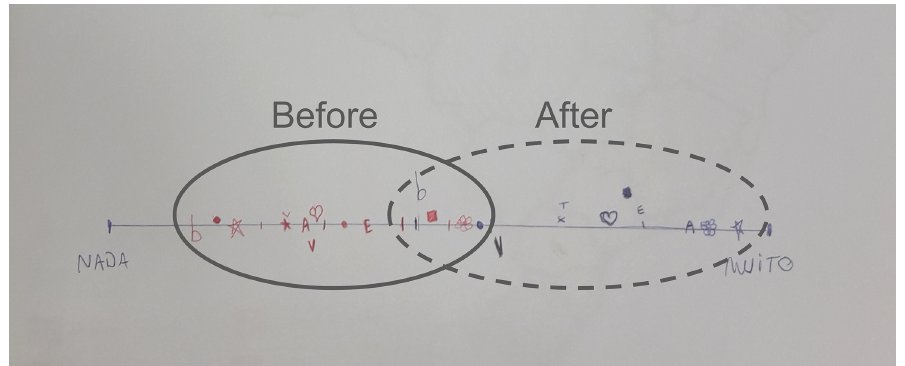
Figure A16. Chart illustrating the evolution of participants’ perception of learning about climate risk in the third training. Each symbol represents a participant, and colours represent the temporality (before and after the lecture). The circle with a continuous line encompasses the perception of the participants at the beginning of the lecture, whereas the circle with a dashed line embraces the perception at the end of the